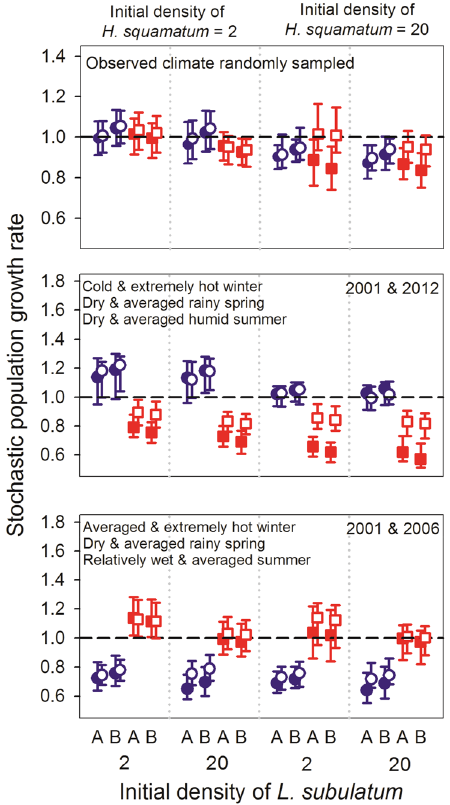
Figure 5. Effect of varying initial densities (2 and 20 individuals m −2 ) of both species on the stochastic population growth rate under different climatic conditions and when recruitment is increased tenfold. Open symbols represent simulations where the interaction between H. squamatum and L. subulatum was null, whereas filled symbols represent simulations where the interaction was considered. Stable population growth rate (λ = 1) is marked with a dashed horizontal line in all plots. The letters A and B in the X axis indicate blocks. See Supplementary Table S10 for exact values of climatic